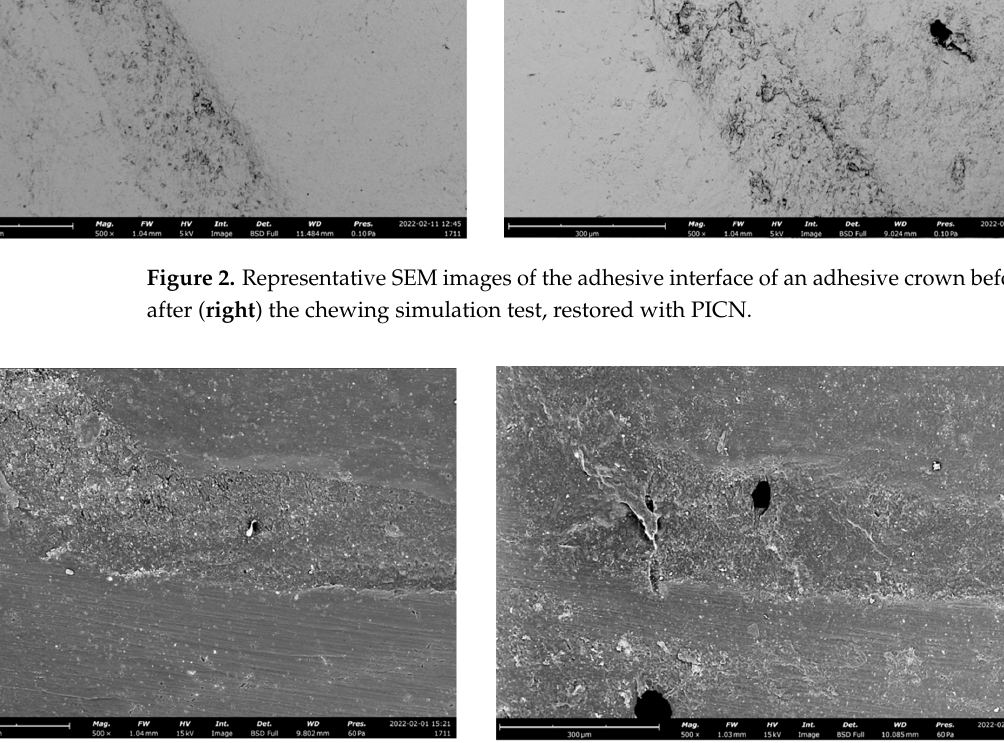
Figure 3. Representative SEM images of the adhesive interface of an occlusal veneer before ( left ) and after ( right ) the chewing simulation test, restored with PICN.